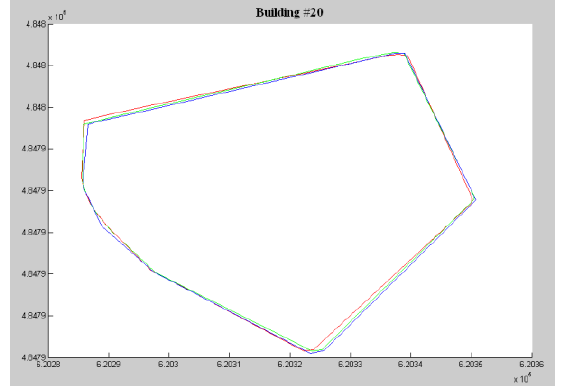
Figure 2. Results from 3D conformal and ICP